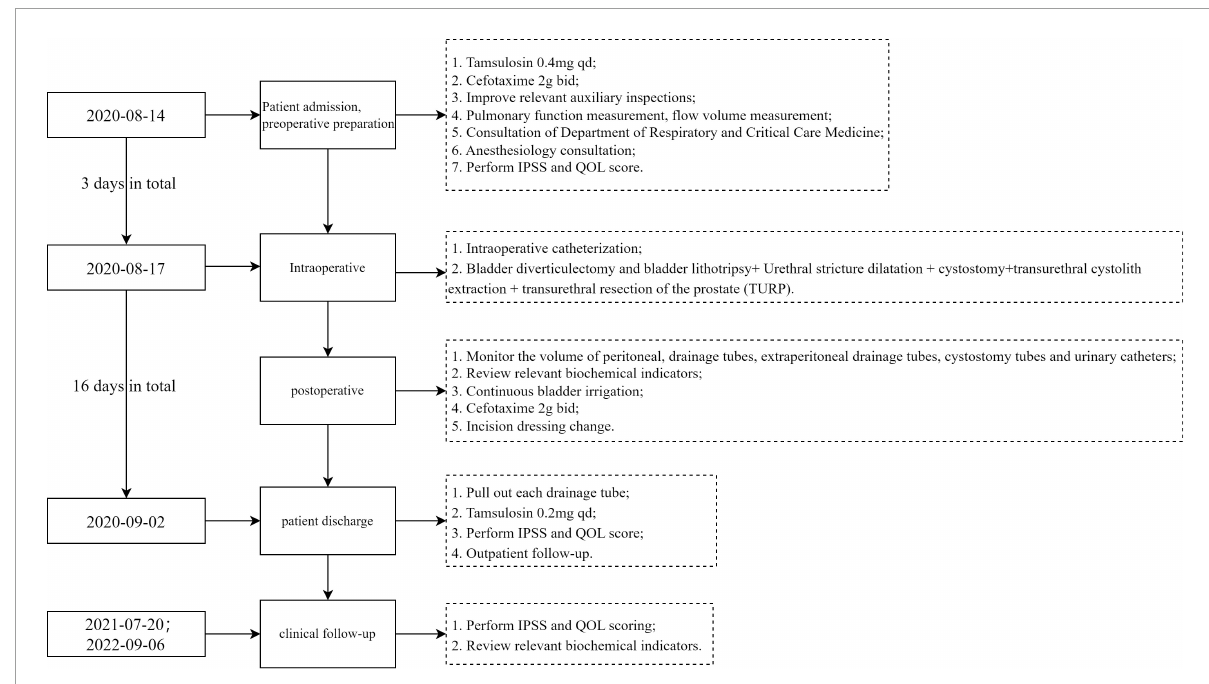
FIGURE1 Diagnosis and treatment flow chart. This flowchart only includes the key events in the diagnosis and treatment process; IPSS, international prostate symptom score; QOL, quality of